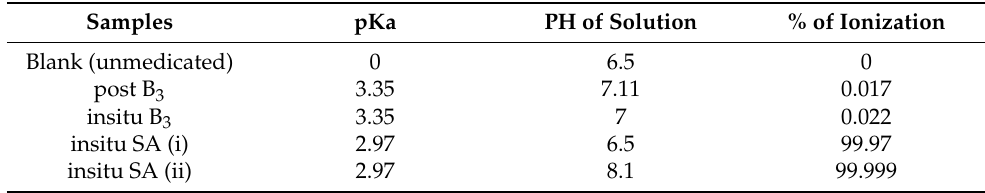
Table 4. The percentage of ionization and pKa of the actives at the pH of the solution used for the loading method (deionized